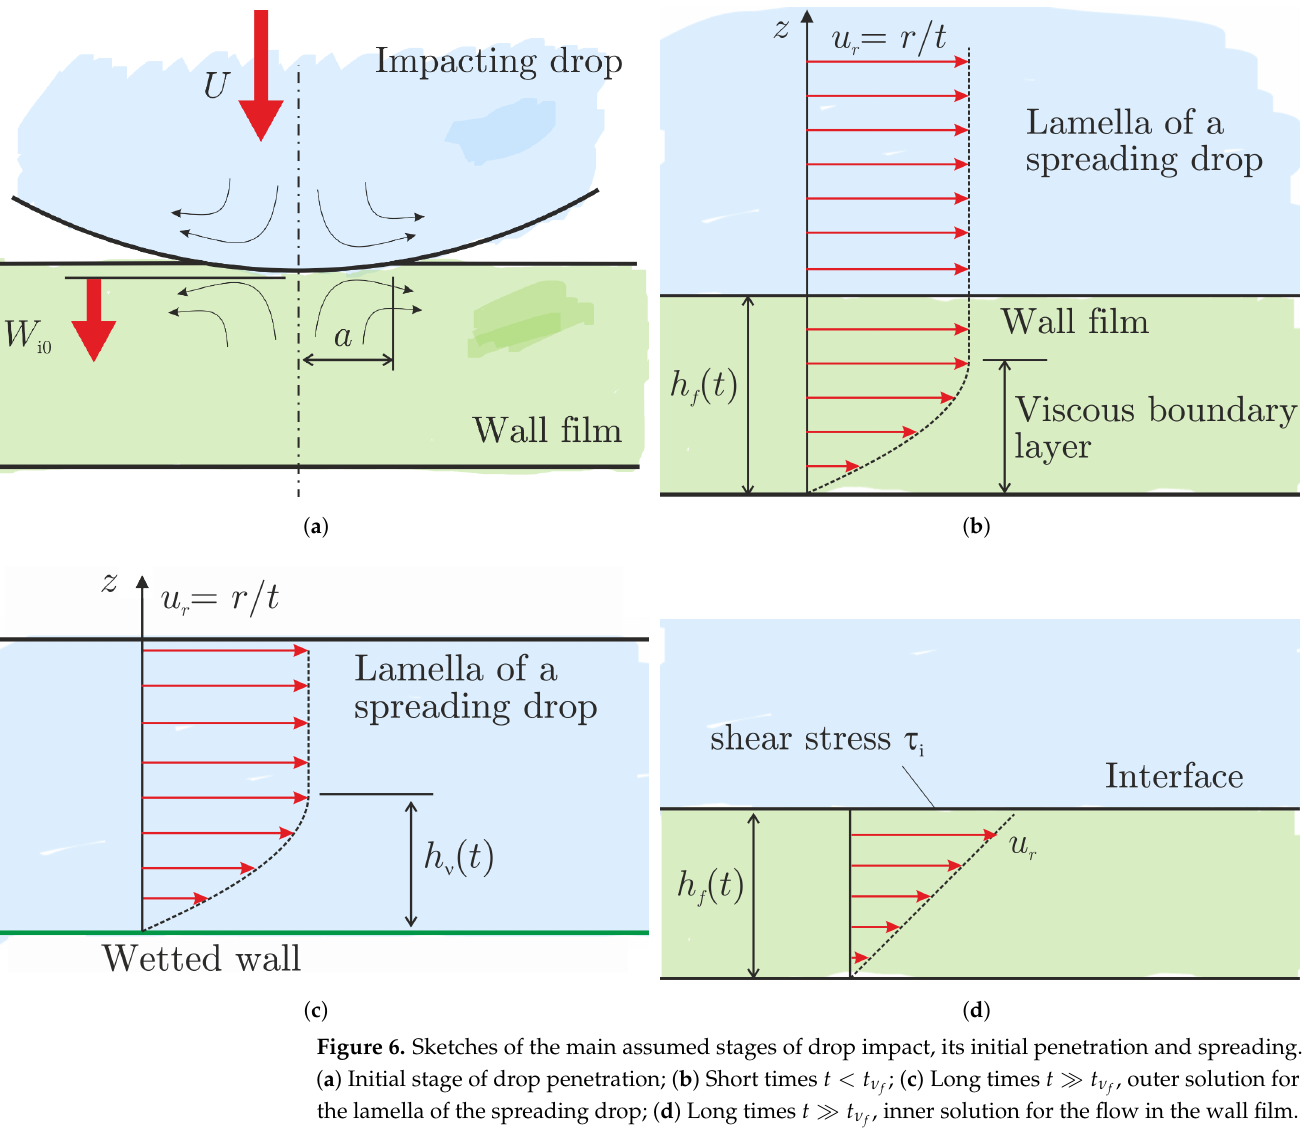
Figure 6. Sketches of the main assumed stages of drop impact, its initial penetration and spreading. ( a ) Initial stage of drop penetration; ( b ) Short times t < t ν the lamella of the spreading drop; ( d ) Long times t (cid:29) t ν